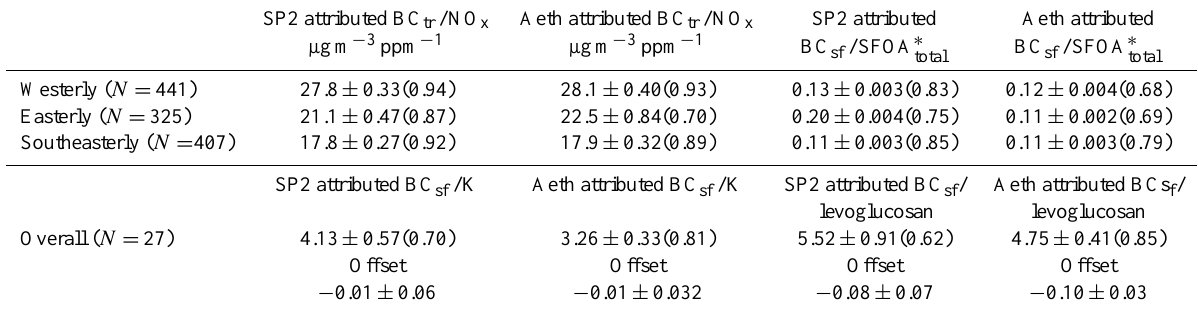
Table 4. The correlations between BC tr vs. NO x , and BC sf vs. SFOA total , potassium and levoglucosan. The BC tr and BC sf attributed by the SP2 and Aethalometer method are shown. Daily averaged potassium and levoglucosan are used, with a total of days’ worth of data used for the linear regression. ∗ Denotes a linear regression constrained to an intercept of